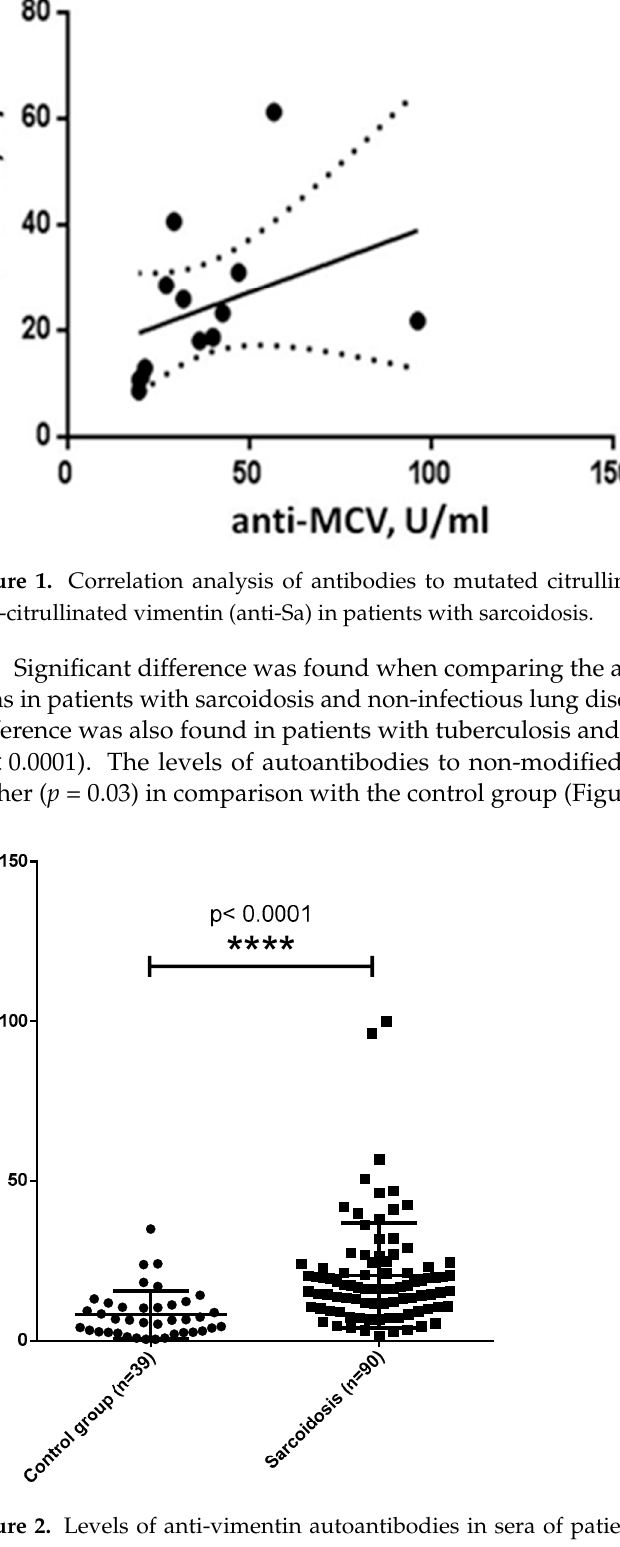
Table 4. Antibodies to mutated citrullinated vimentin (anti-MCV) in patients with acute sarcoidosis (Löfgren’s syndrome). Patients with Sarcoidosis, n = 93